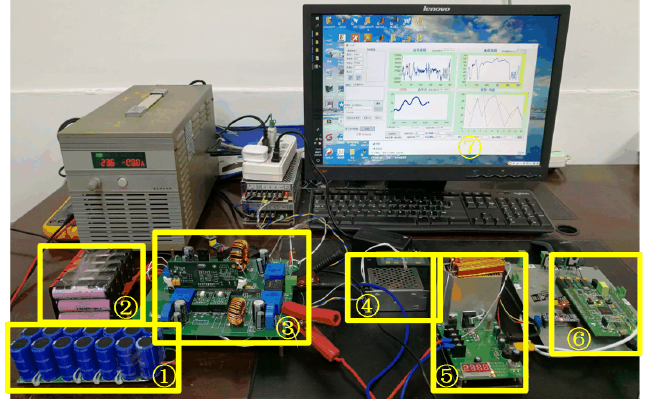
Figure 8. An HESS physical experimental testbed. The modules are as follows: (1) Supercapacitors, (2) Batteries, (3) Two buck-boost converters, (4) Controllable constant current source, (5) Controllable constant current load, (6) MCU STM32F407, and (7) PC software-Driving